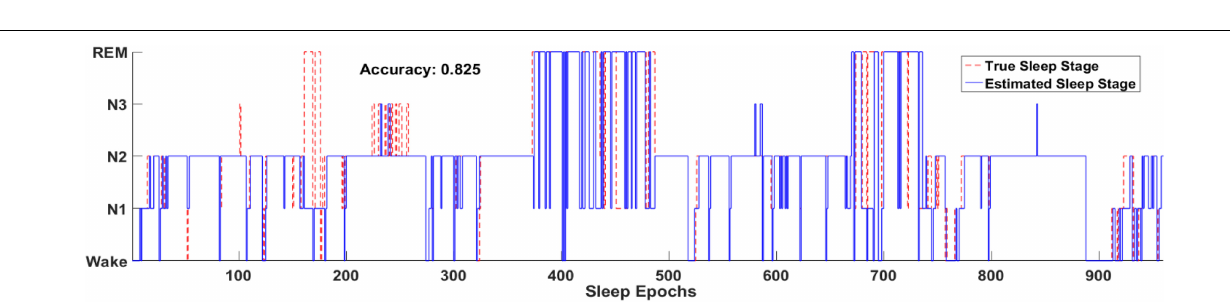
FIGURE 7 | The normalized confusion matrices in the first and second row are obtained via the 5-class task and 4-class task, respectively. The first and second columns are obtained from the MASS and Sleep-EDF databases, respectively.